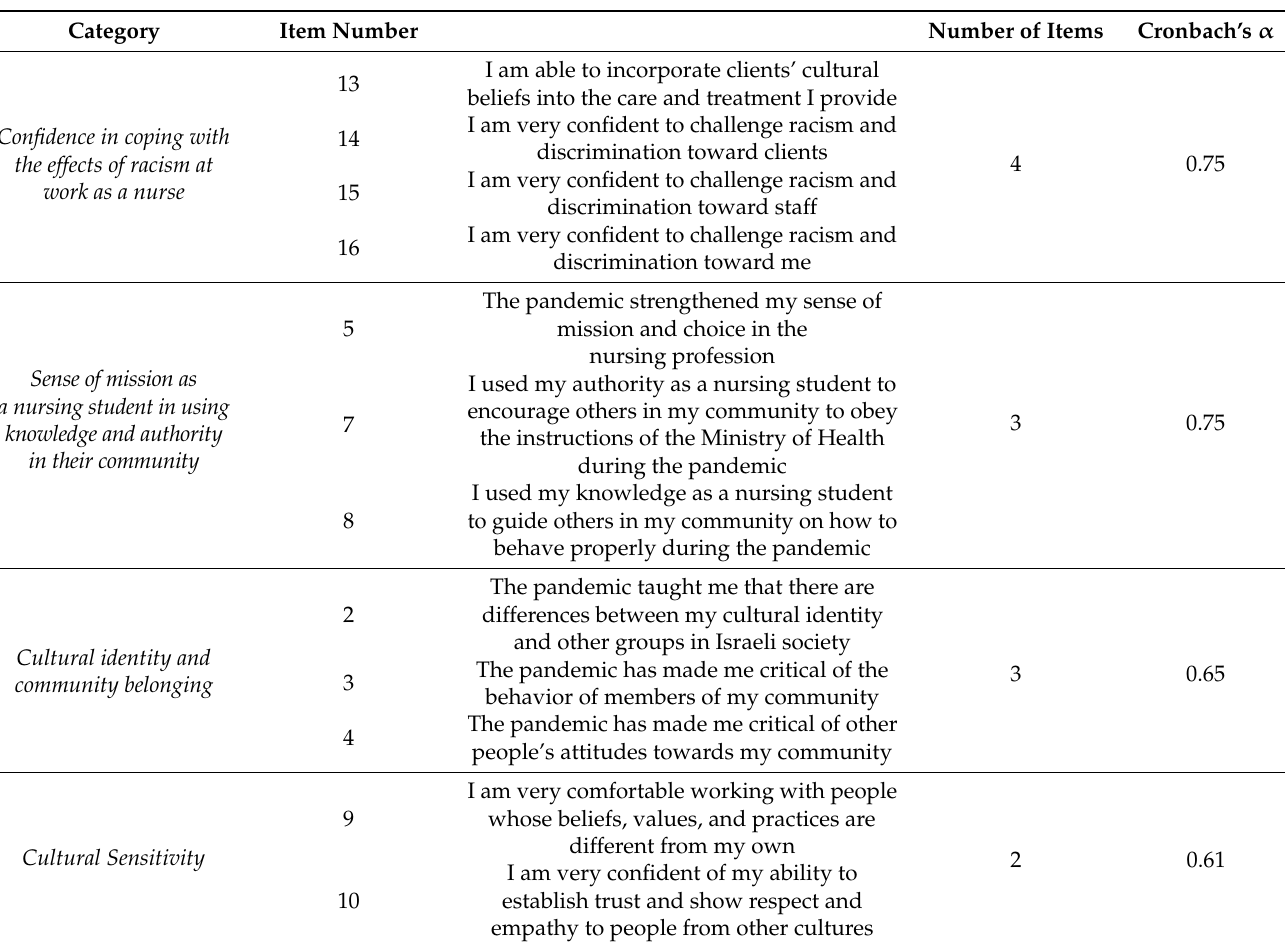
Table 1. Categories, Items, and Cronbach’s α